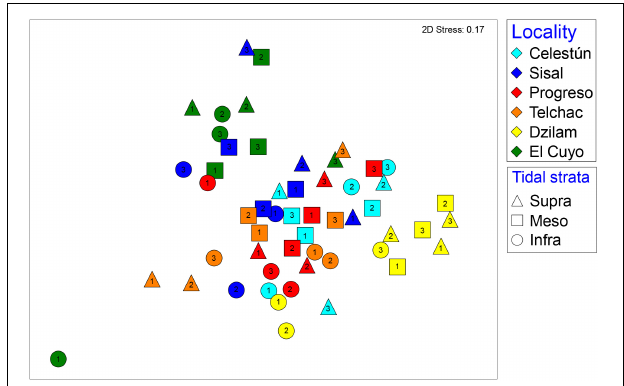
FIGURE 2 | Non-metric Multidimensional Scaling of centroids for the interaction term Strata × Site (Locality), of macrobenthic organisms in sandy beaches of Yucatán. The abundances of species were log-transformed. The coefficient of dissimilarity used was Bray-Curtis. Numbers over each symbol represent the site ID.